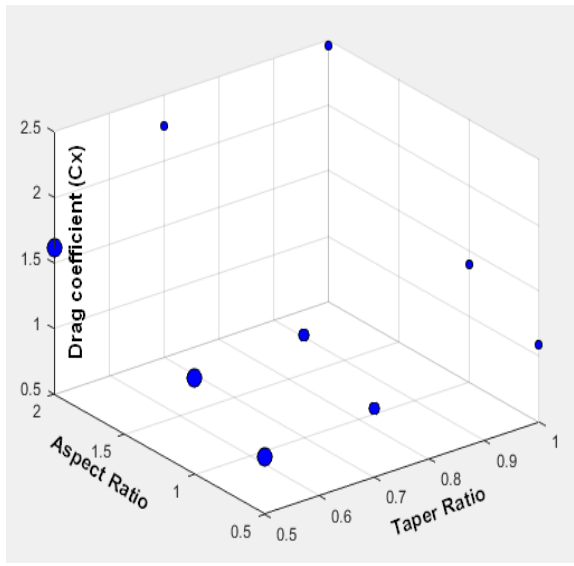
Figure 12. Stability coefficient as a function of taper and aspect ratios